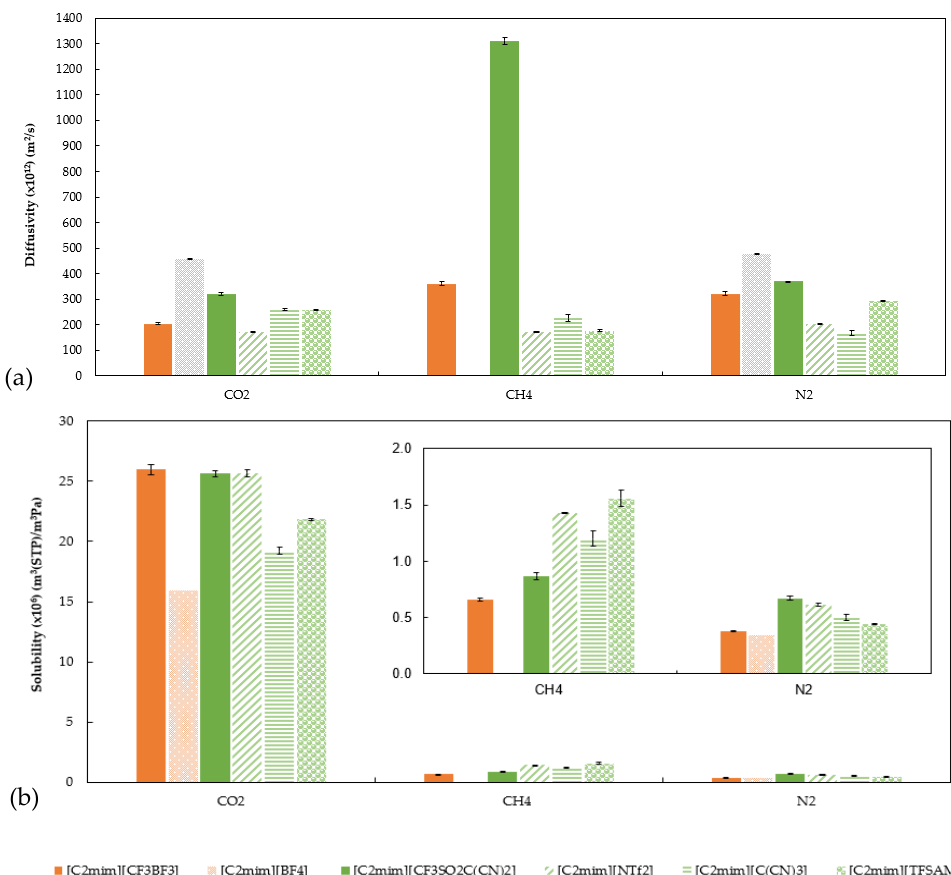
Figure 4. ( a ) Gas diffusivities (D) and ( b ) solubilities (S) of [C 2 mim][CF 3 BF 3 ] and [C 2 mim][CF 3 SO 2 C(CN) 2 ] at T = 293.15 K. In some cases, the standard deviations are very small and cannot be visualized. Values of [C 2 mim][NTf 2 ] were taken from Tomé et al. [28], [C 2 mim][C(CN) 3 ] taken from Tomé et al. [29], [C 2 mim][TFSAM] taken from Gouveia et al. [44], and [C 2 mim][BF 4 ] taken from Li et al. [58] Table 4. Gas permeability 1 (P), diffusivity (D), and solubility (S) of the [C 2 mim][CF 3 BF 3 ] and